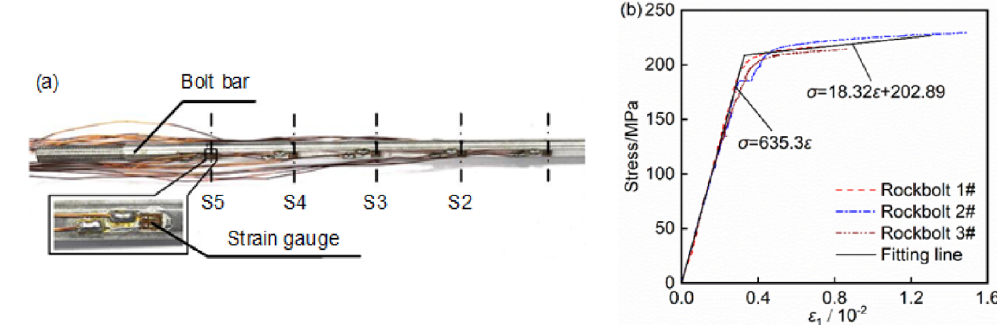
Figure 5. ( a ) Mode bolt used in experimental; ( b ) Stress–strain curve of bolt.